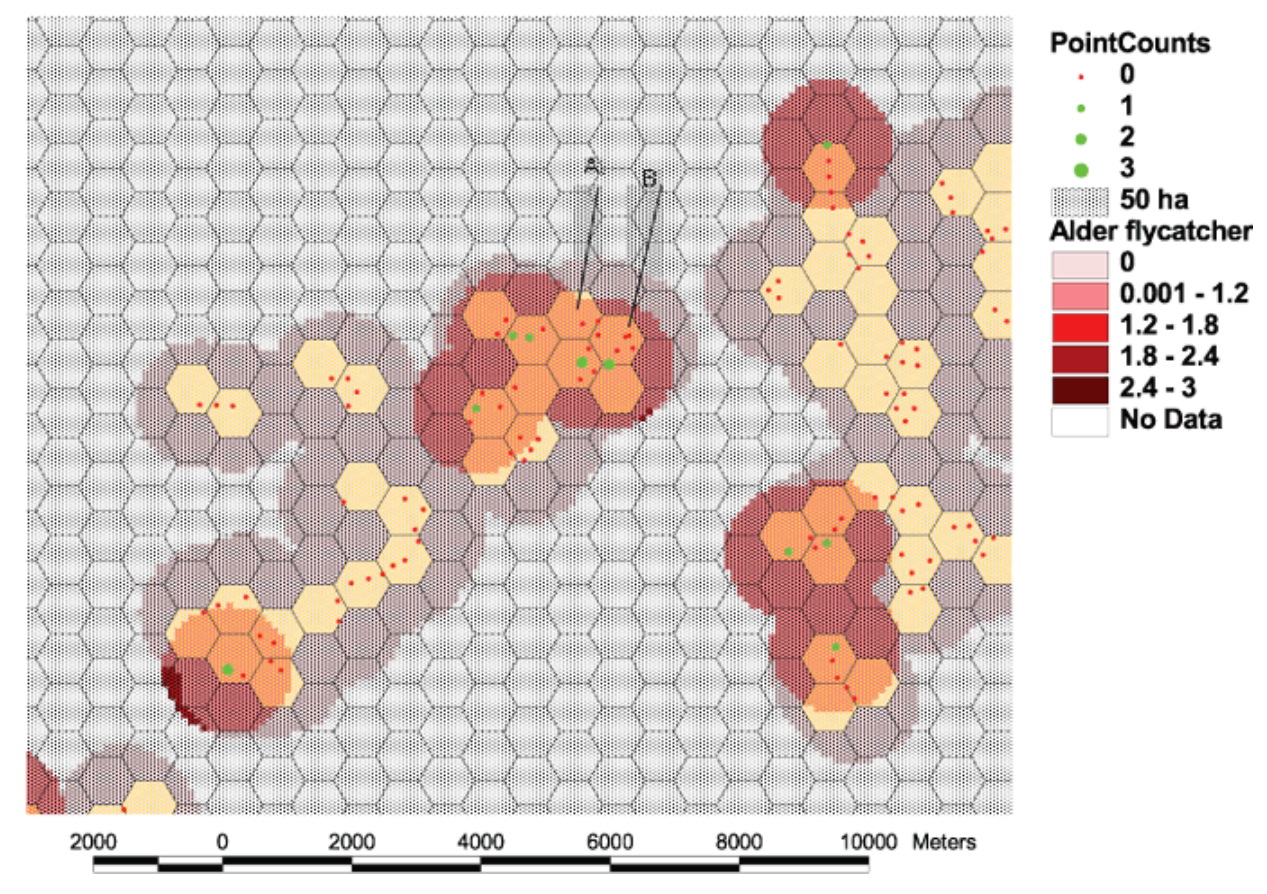
Fig. 1. Overlay of 50-ha hexagonal analysis cells on kriged surface of Alder flycatcher point counts. Points with <0 counts are colored green. Interpolation is limited to 1000 m. Only cells that intersect at least one point count (orange and cream colored) are selected for analysis. Note that in cells A and B, estimated relative densities are >0, even though no point counts>0 occurred within the cells. Cell B contributes only one data value to the analysis, even though five point counts occur within the cell; thus cells A and B contribute equal weight to the